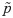
Simulated bottleneck with changing sex-bias.Test for changing sex-bias applied to bottleneck simulations with a proportion of females of p1 outside the bottleneck and p2 during the bottleneck. (A) Off-diagonal entries are power: values greater than 0.85 are in blue, values between 0.85 and 0.10 are in light yellow, and values less than 0.10 are in orange. Entries on the diagonal are false positive rates and are in gray. (B, C) Data was simulated with a female bias outside the bottleneck (p1 = 0.8) and a varying proportion of females during the bottleneck, p2. Our method produces separate estimates for p1 and p2 (p˜, in blue), while the the π-based estimator produces one estimate (pπ, in red). Bias of estimators of the proportion of females (B) outside the bottleneck, p^−p1, and (C) during the bottleneck, p^−p2, is shown for both methods. The π-based estimator is biased when p1 and p2 differ (here, when p2 is not 0.8), whereas our estimator is unbiased.